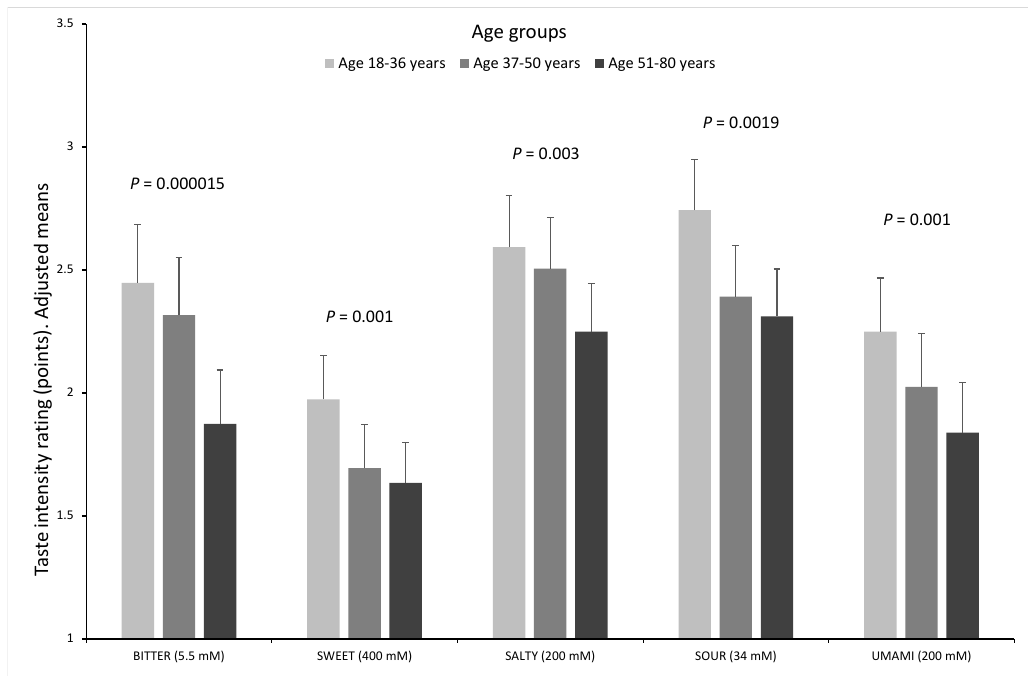
Figure 2. Intensity rating (points) for the five basic tastes (bitter (PROP), sweet, salty, sour and umami) by age group (18–36 years ( n = 342), 37–50 years ( n = 329) and 51–80 years ( n = 349)) at the maximum concentration (concentration V) of the tastants tested (PROP 5.5 mM; sucrose 400 mM, NaCl 200 mM; citric acid 34 mM; and MPG 200 mM), in the whole population ( n = 1020). Values are adjusted means (model 3) including sex, age, diabetes, body mass index, smoking and medications. Age groups are based on tertiles. p -values show the statistical significance for the age differences in taste perception among groups for each taste after adjustment for covariates (model 3). Error bars are